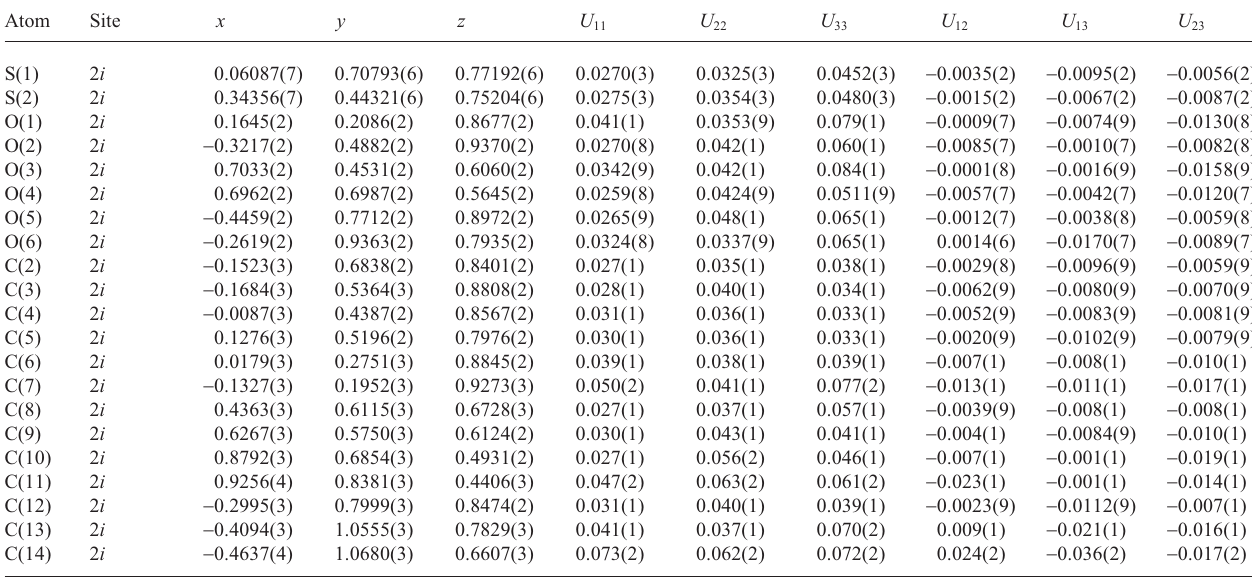
Table 3. Atomic coordinates and displacement parameters (in Å 2 )